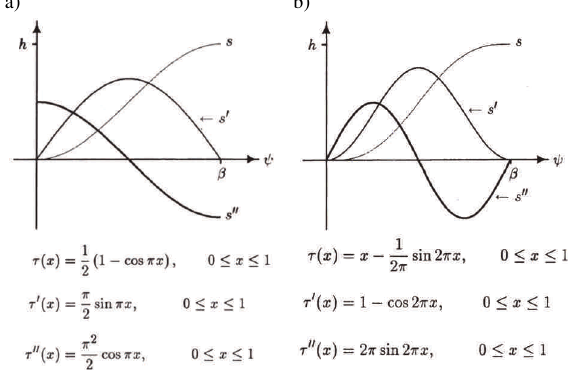
Fig. 3. Displacement, velocity and acceleration in: a) harmonic, b) cy- cloidal motion [8]